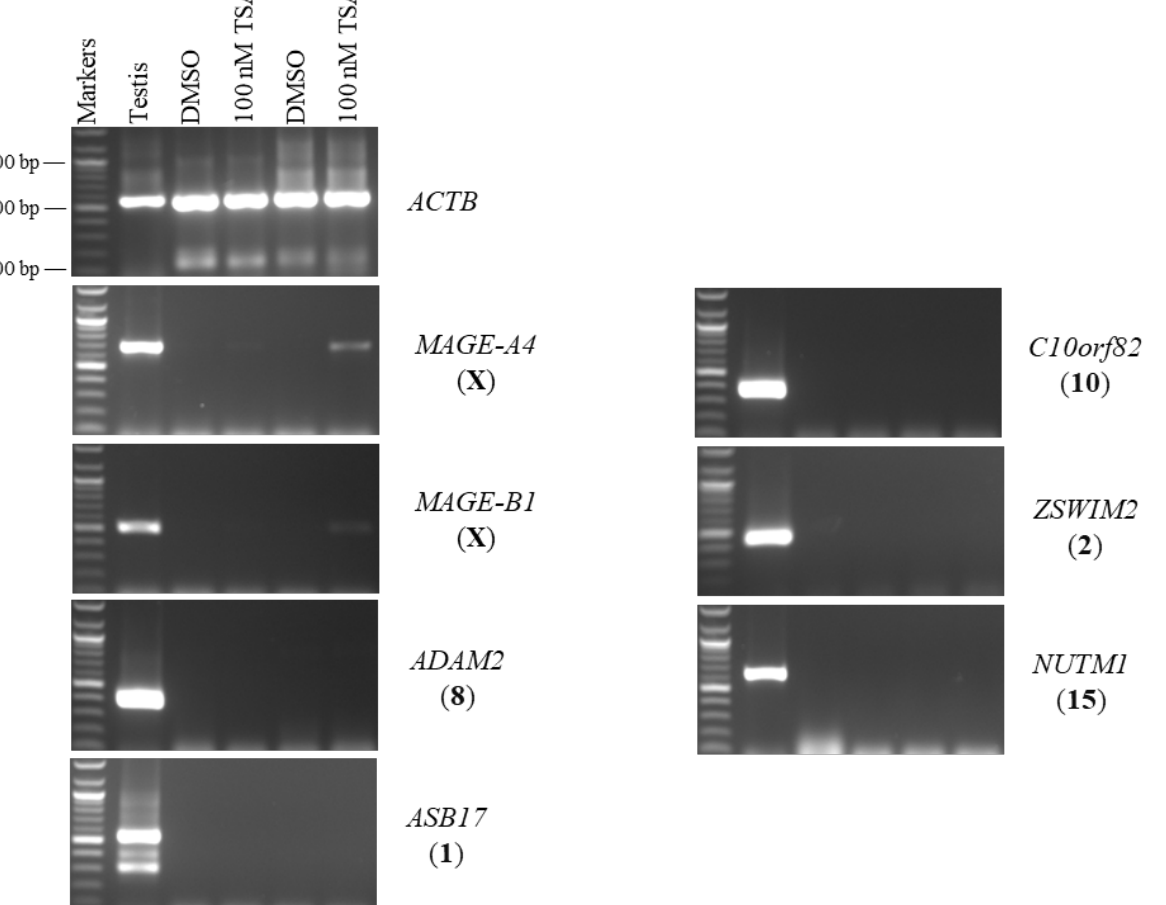
Figure 7. The effects of TSA treatments on testis-specific gene expression profiles in the Caco-2 and HCT116 cancer cell lines. The expression of ADAM2 , ASB17 , C10orf82 , ZSWIM2 , and NUTM1 genes is shown on agarose gels following treatment with 100 nM TSA for 48 h. The testis sample served as a positive control for primer efficiency. Control Caco-2 and HCT116 cells were treated with DMSO, as DMSO was the solvent utilized in the TSA solution. The positive control for the cDNA samples is the expression of the ACTB gene. The official names of the genes are written to the right of the agarose gel images, and the location of each gene on the chromosomal is written in parentheses on the